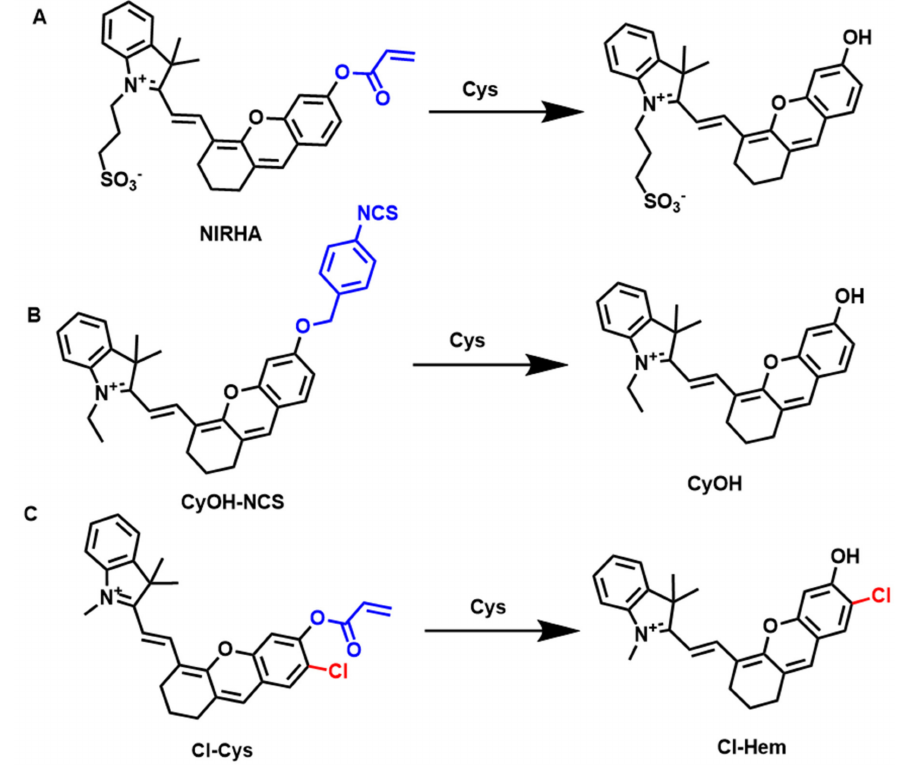
Figure 13. The response mechanisms and chemical structures ( A ) NIRHA, ( B ) CyOH-NCS, and ( C ) Cl-Cys of fluorescent probes for